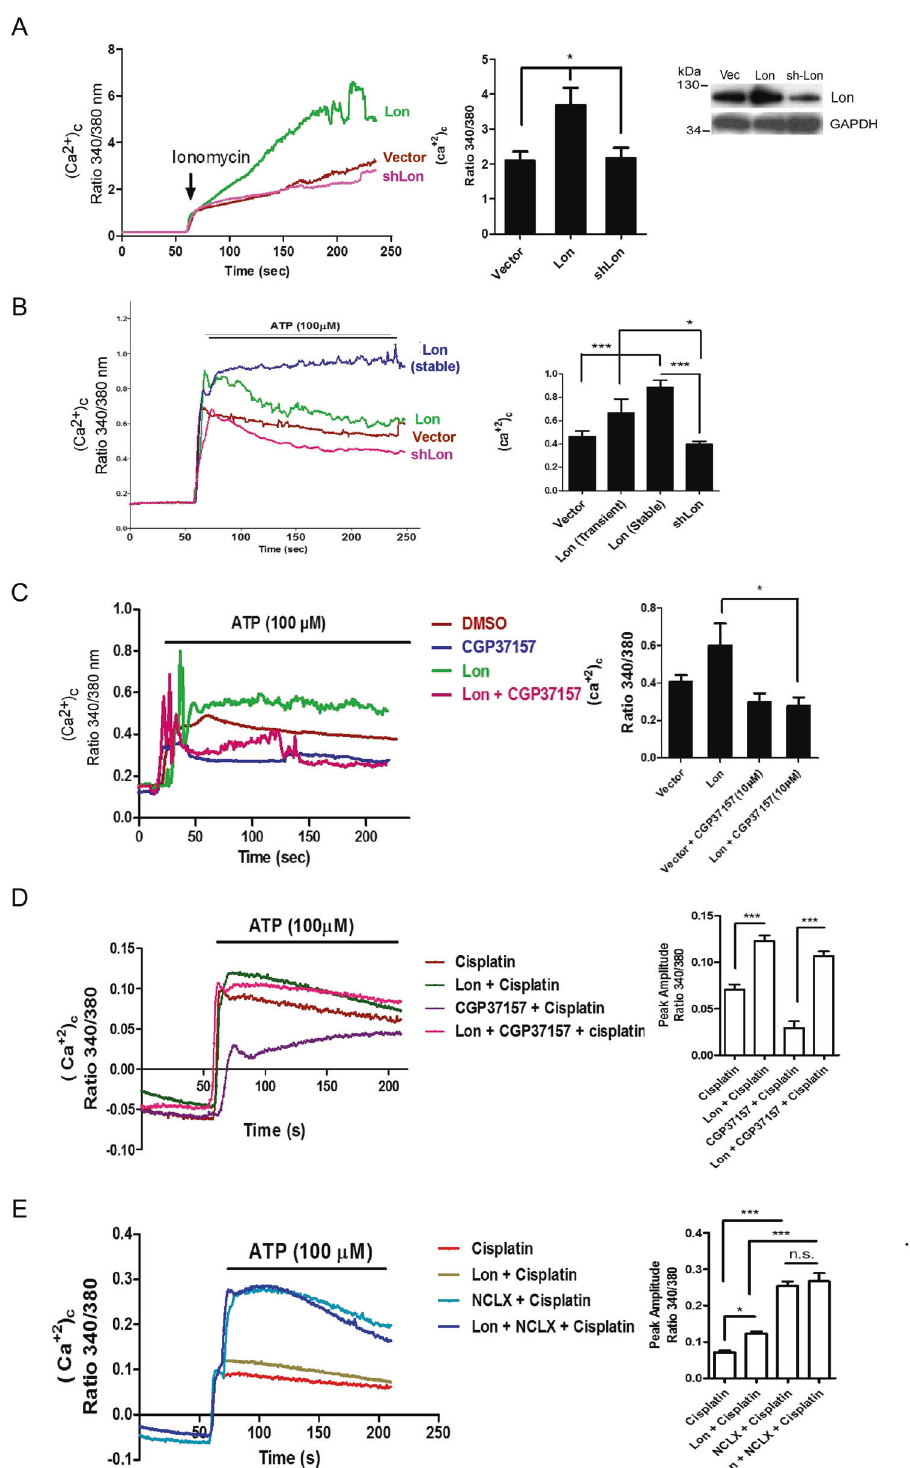
fl uorescence intensity of basal calcium. Cells were seeded in 6-well plates and transfected with ratiometric pericam along with vector or Lon plasmids for 48 h. After incubation, cells were washed with HBSS medium containing Ca 2 + and assayed under Leica live imaging microscope. (Ca 2 + ) mito were measured by ratiometric pericam with alternative excitation of 380 and 488 nm fi lters and emission of 510 nm. First basal levels were measured in presence of buffer and later cisplatin or ATP agonist was added and made further readings. Analysis was done using